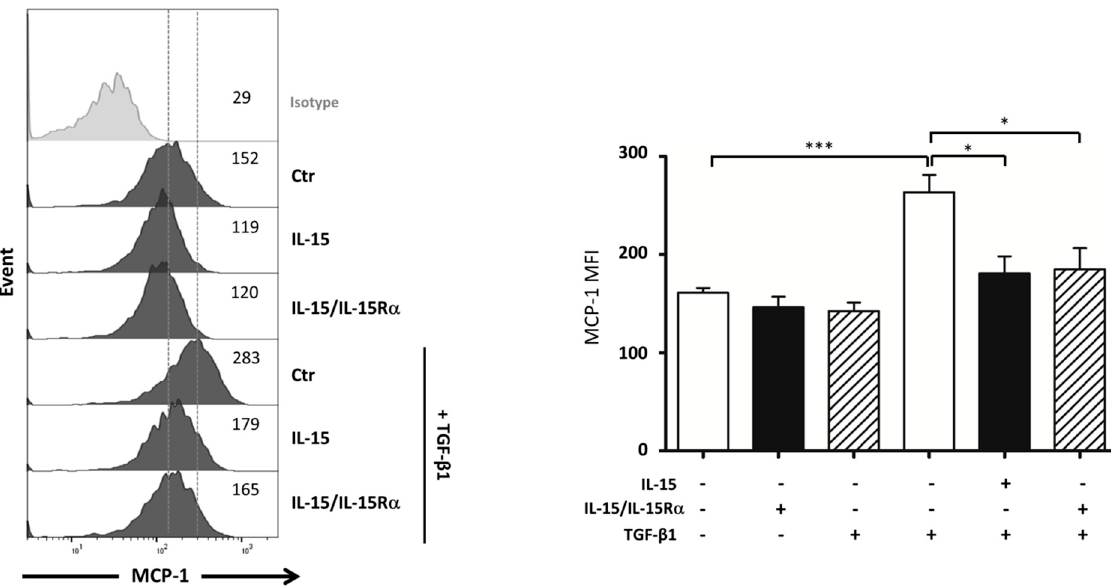
Figure 8. TGF- β 1-increased MCP-1 expression in myofibroblasts is inhibited by both IL-15 treatments. Intracellular expression of MCP-1 was analyzed by flow cytometry in 48 h-treated myofibroblasts with TGF- β 1 (2.5 ng/mL). Left, Representative staining of one experiment is shown. The dark-colored histograms correspond to cells incubated with an anti-MCP-1 antibody, and gray histograms correspond to cells incubated with the isotype-matched control antibody. Mean fluorescence intensity values are shown at the right of each histogram. Right, Graphs represent the relative expression of MCP-1 in four independent experiments. Data are shown as means ± SEM (* p < 0.05, *** p < 0.001, n = 4).